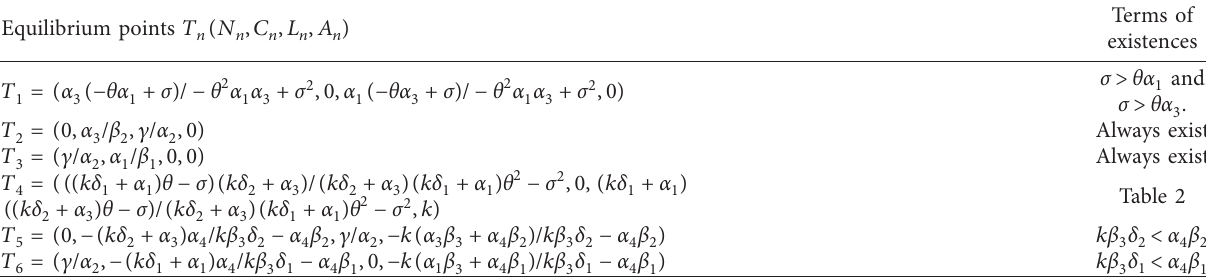
Table 3: The existences of equilibrium points.